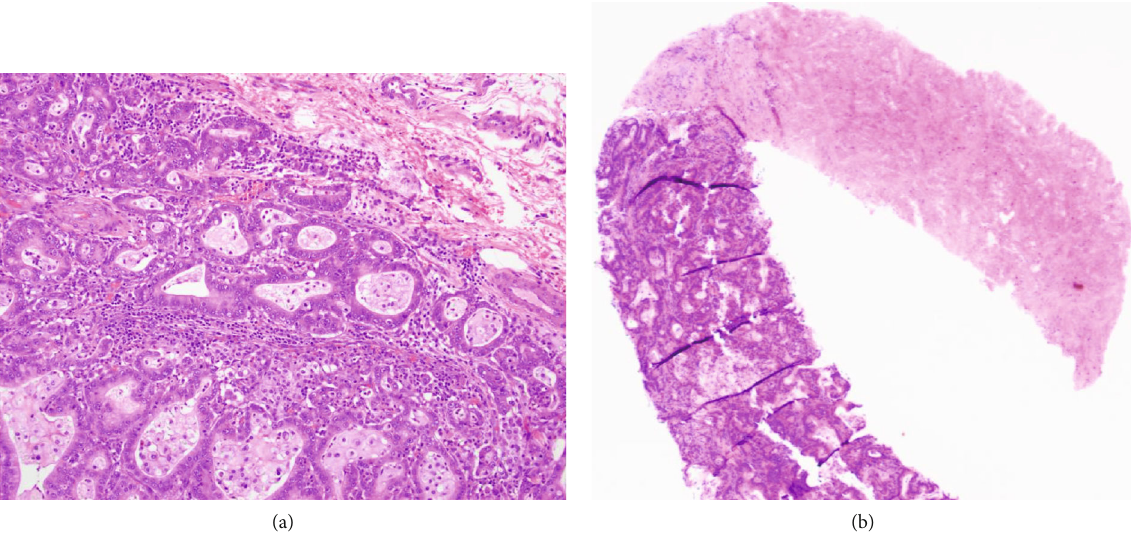
Figure 8: Hematoxylin and eosin-stained histology slides of primary gastric adenocarcinoma at 4x magni fi cation, moderately-di ff erentiated with solid nests and glandular architecture (a). Identical pattern found after biopsy of the abdominal wall mass (b) at 1x magni fi